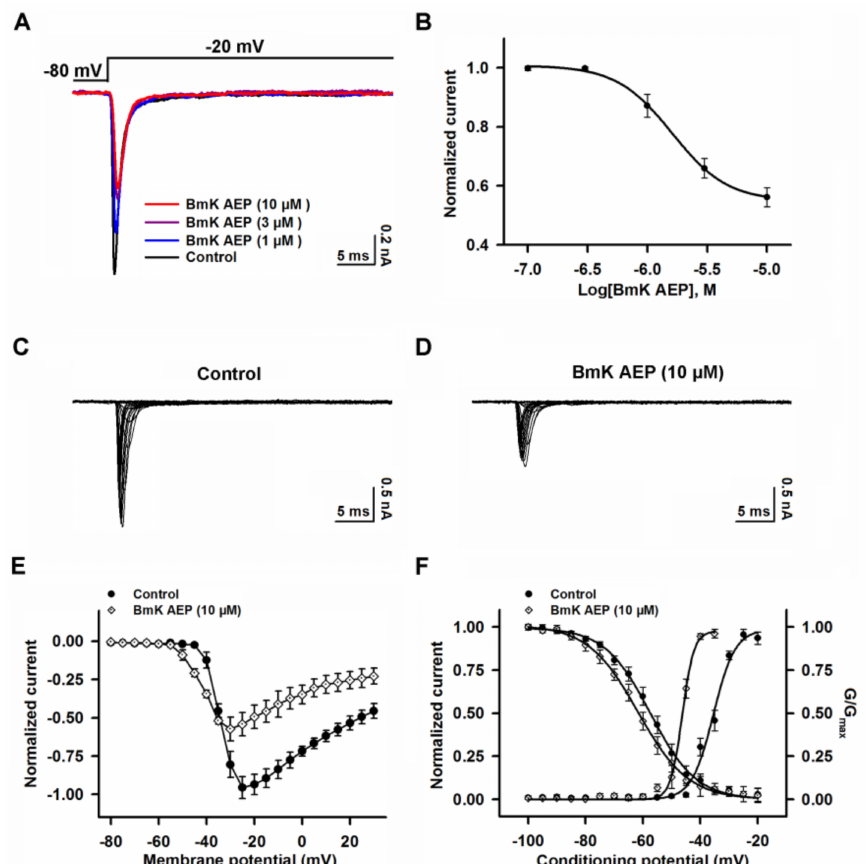
Figure 5. Influence of BmK AEP on hNa v 1.3 expressed in HEK-293 cells. ( A ) Representative traces of BmK AEP suppression of the Na v 1.3 peak current. Na + currents were elicited by a 50-ms depolarization to − 20 mV from a holding potential of − 80 mV. ( B ) Concentration–response relationship curve of BmK AEP inhibition of Na v 1.3 currents. ( C , D ) Representative traces of Na v 1.3 currents in the